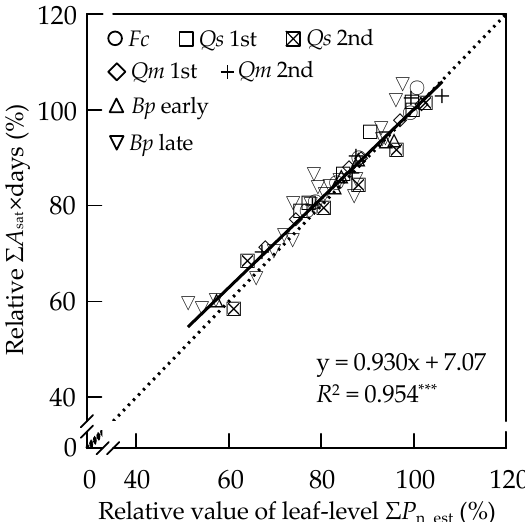
Figure 3. Relationship between the relative value of leaf-level Σ P n_est (%) and relative Σ A sat × days (%) in the 1st flush leaves of F. crenata ( Fc ), the 1st and 2nd flush leaves of Q. serrata ( Qs 1st and Qs 2nd, respectively), the 1st and 2nd flush leaves of Q. mongolica var. crispula ( Qm 1st and Qm 2nd, respectively), and the early and late leaves of B. platyphylla var. japonica ( Bp early and Bp late, respectively). Datasets for the charcoal-filtered air (CF) treatment were not plotted. The relationship was analyzed by linear regression. Solid and dashed lines indicate the regression line and 1:1 line, respectively. The equation and the coe ffi cient of determination ( R 2 ) of the regression line are indicated in the figure. Significance for the R 2 is shown: *** p <